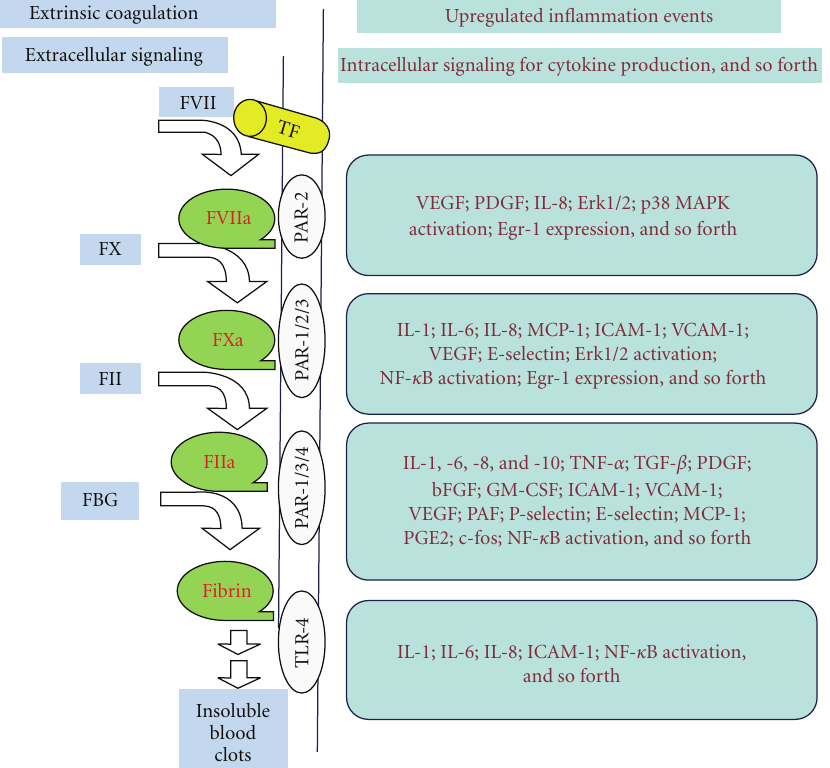
Figure 2: TF hypercoagulability and inflammation. TF-initiated extrinsic coagulation (left panel) essentially proceeds as extracellular signaling and results in the generation of active serine protease (coagulant mediators: FVIIa, FXa, and FIIa) derived from their corresponding zymogen activations. FBG is cleaved by FIIa to produce fibrin that is polymerized and cross-linked to yield insoluble blood clots. Such TF extracellular signaling activates cells for proinflammation. Through cell receptors on plasma membrane, signals from the coagulant mediators (FVIIa, FXa, and FIIa) as well as fibrin mediate diverse intracellular activation and the production of proinflammatory mediators (right panel) including cytokines, adhesion molecules, and growth factors, PAR: protease activated receptor; TLR: Toll-like receptor; IL: interleukin; NF κ B: nuclear factor kappa